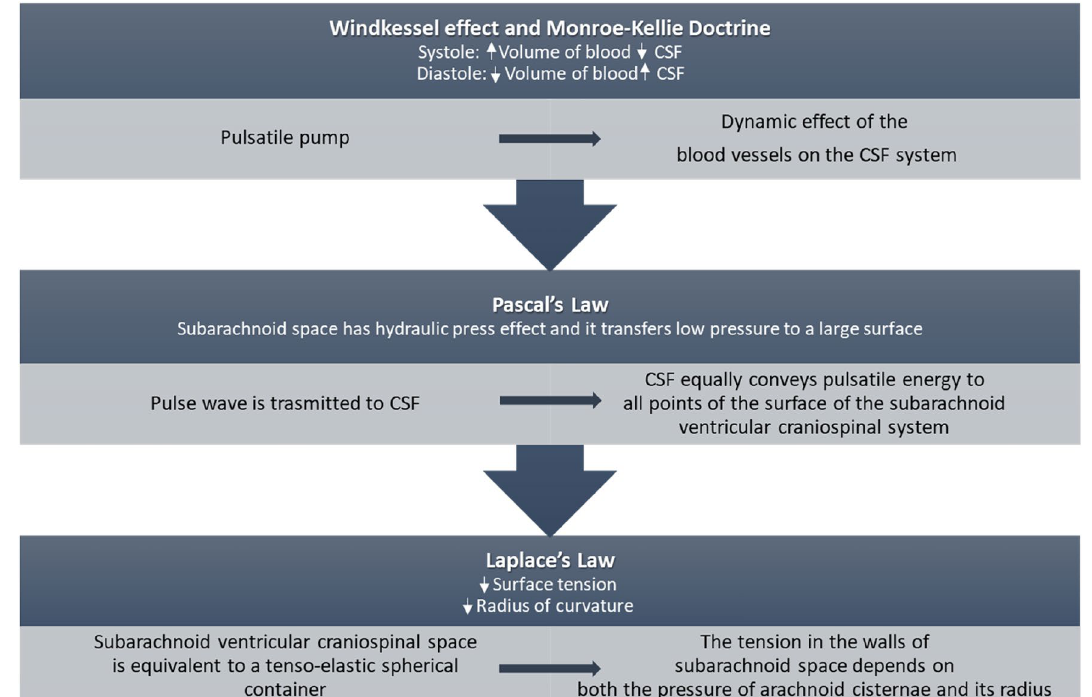
Figure 2. Pressure distribution in the subarachnoid ventricular craniospinal